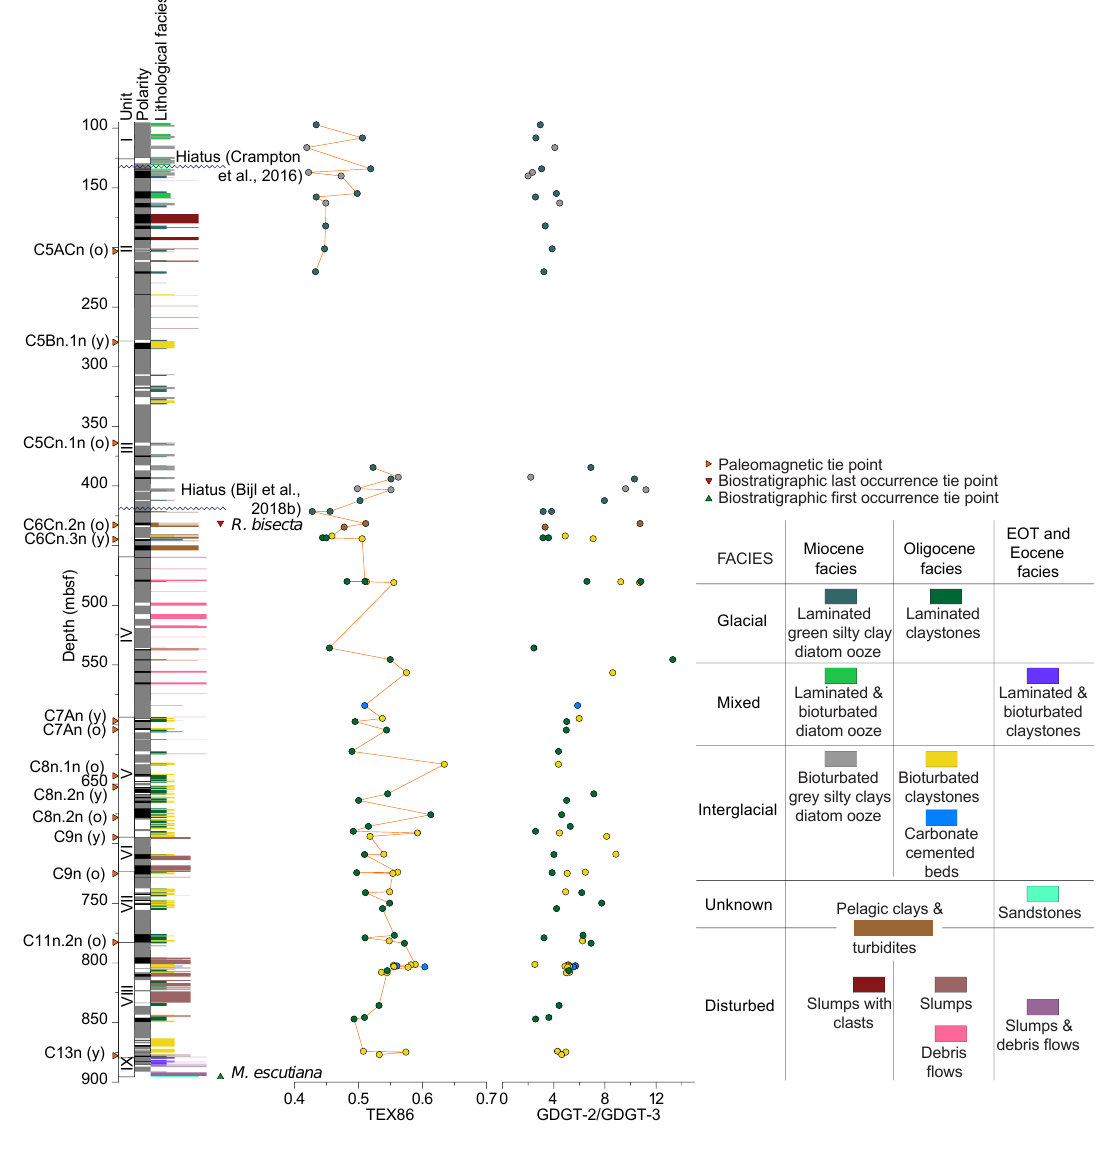
Figure 2. Lithology, TEX 86 values, and GDGT-2 / GDGT-3 ratios of Hole U1356A plotted against depth (mb.s.f.) with units according to Escutia et al. (2011) and chronostratigraphic tie points and paleomagnetic polarities obtained from Tauxe et al. (2012), adjusted by Crampton et al. (2016) and Bijl et al. (2018b). Depositional facies and interpretation are indicated with colors following Salabarnada et al. (2018); see legend to the right. Colors of the TEX 86 and GDGT-2 / GDGT-3 values reflect the lithology from which they have been